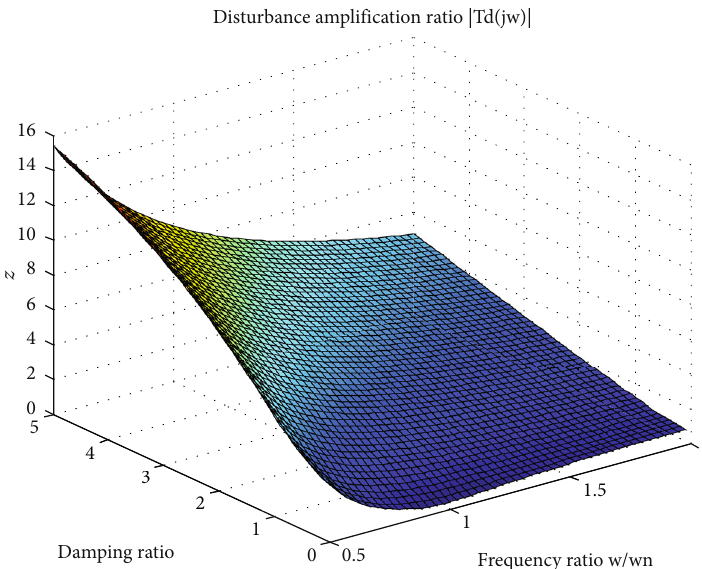
Figure 2: Dependence of disturbance ampli fi cation upon damping ratio and frequency